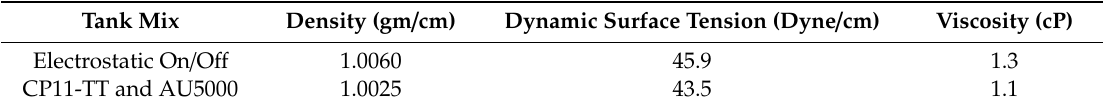
Table 2. Physical properties of the spray